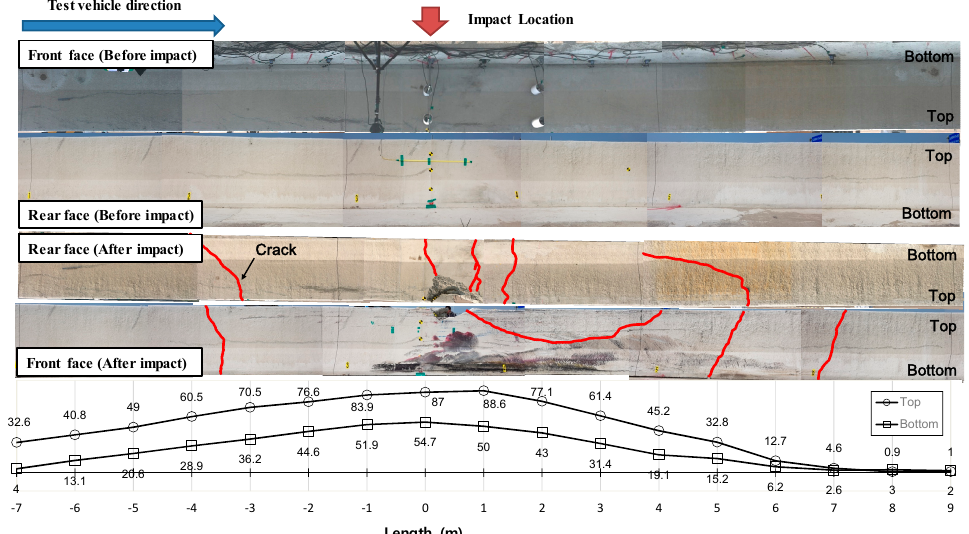
Figure 15. Lateral displacement along longitudinal direction of CMB-17S, measured with respect to several LVDTs.